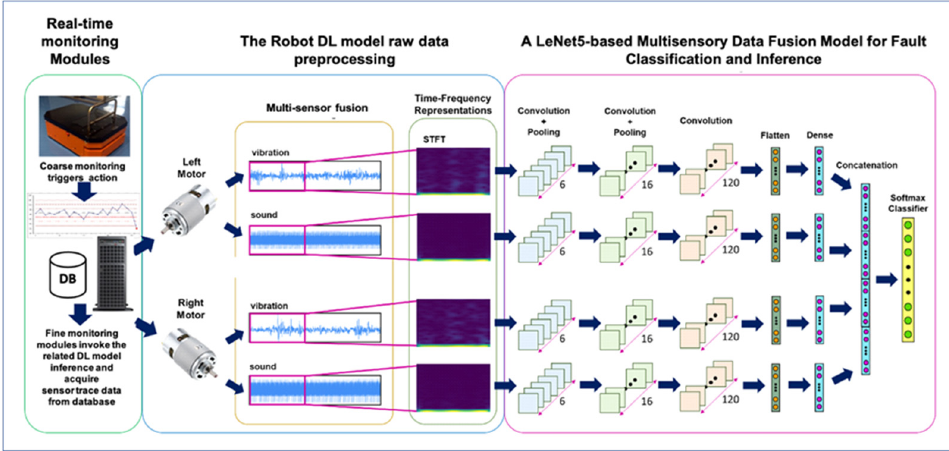
Figure 7. A Sequence of events with Real-time monitoring module involving a DL Model-based Fault Classification task for an autonomous transfer vehicle.